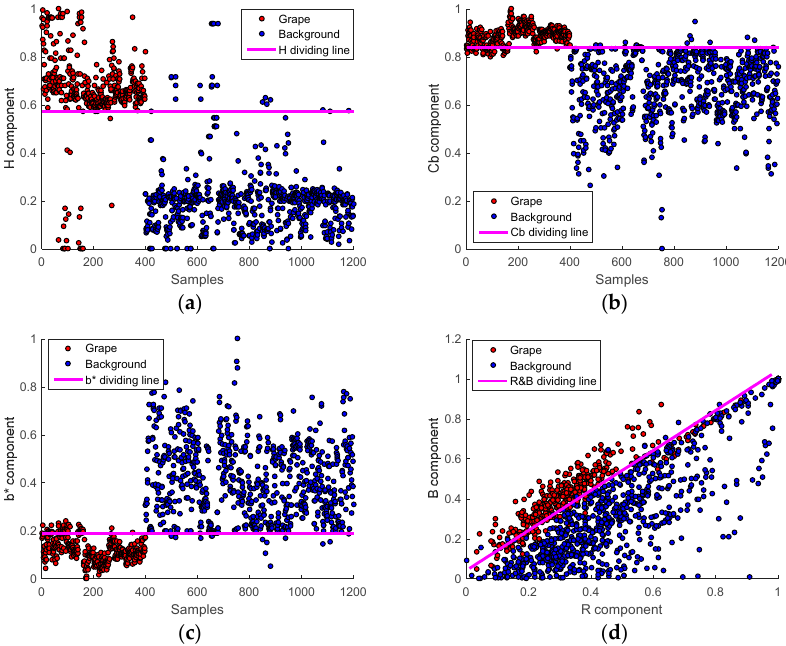
Figure 5. The distribution of average pixel value of 1200 samples on H, Cb, b*, B&R components and the corresponding dividing lines between grape and background ( a ) the dividing line H = 0.5736 and its LCE is 6.75%; ( b ) the dividing line Cb = 0.8405 and its LCE is 8.5%; ( c ) the dividing line b* = 0.1889 and its LCE is 12.08%; and ( d ) the dividing line B = 1.2 × G − 0.05 and its LCE is 10.83%.